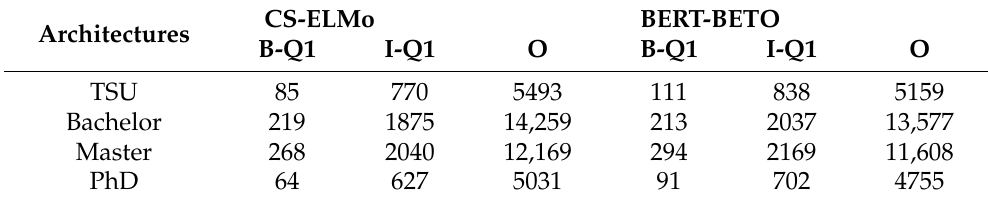
Table 4. Detection results for question Q1: What is going to be done?